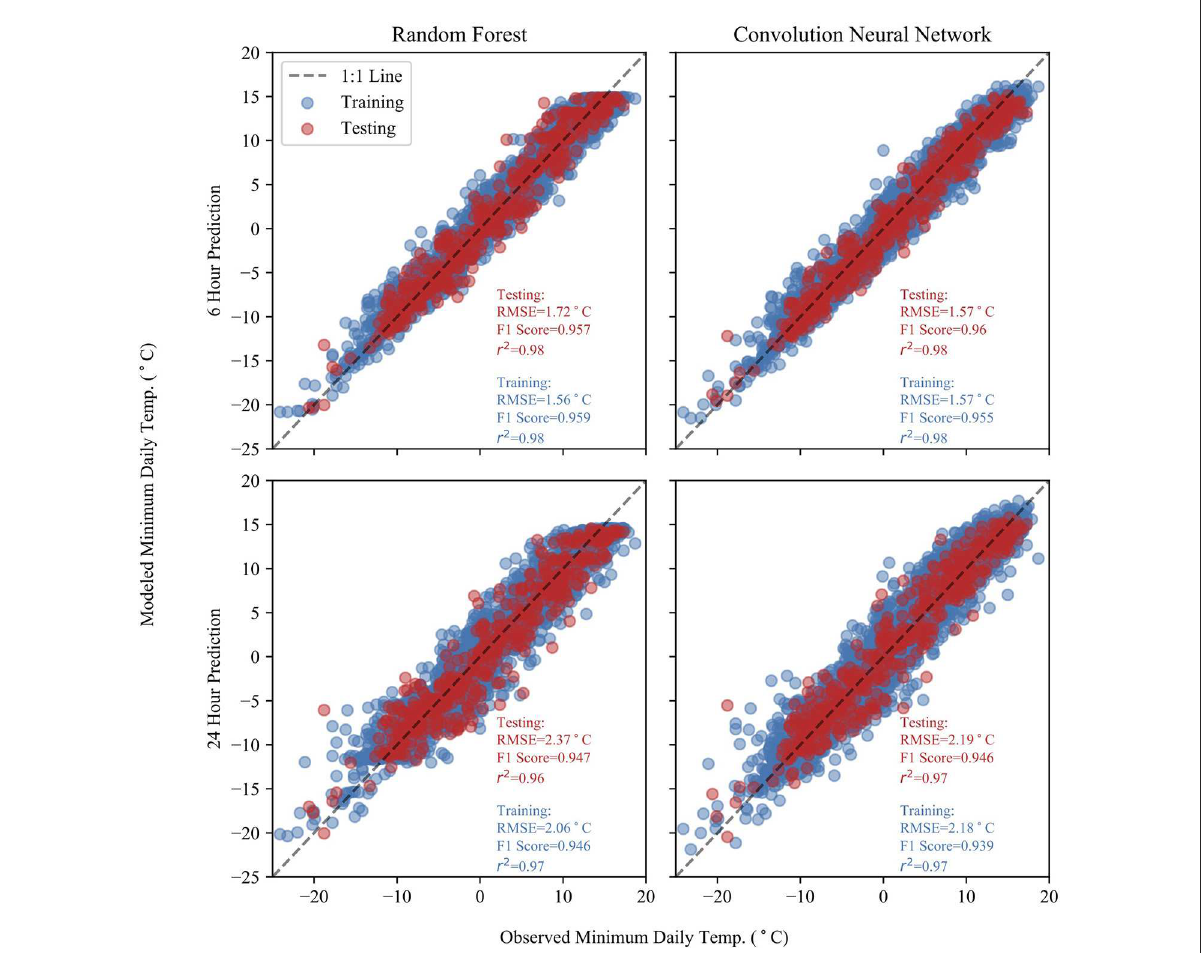
FIGURE3 Observed and predicted temperatures at 6- and 24-h lead-times for both the RF and CNN models. Statistics for the predictions are included for each plot for both testing and training datasets. The predictions show good accuracy with low RMSE